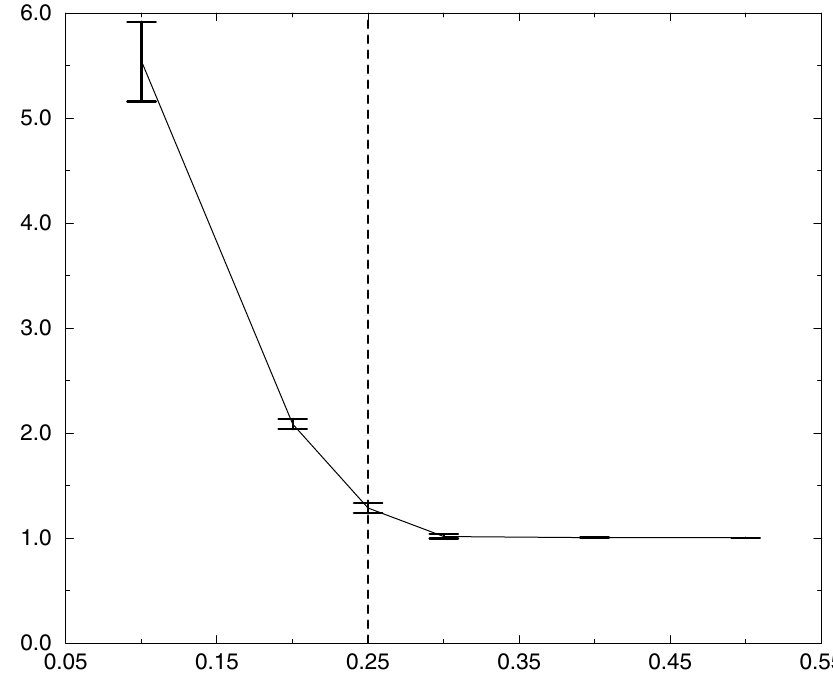
FIG. 1. Emittance growth factor vs initial emittance (eVs) for bunches of 2 (cid:1) 10 11 protons crossing transition in the FMI. Each point is determined by a tracking with 6 : 4 (cid:1) 10 8 macroparticles and a run with 10 8 . The statistically weighted mean is the central value with error bars given by the difference between the two runs. The vertical dashed line is the NMI threshold evaluated either from Hardt’s formulas or the self-bunching